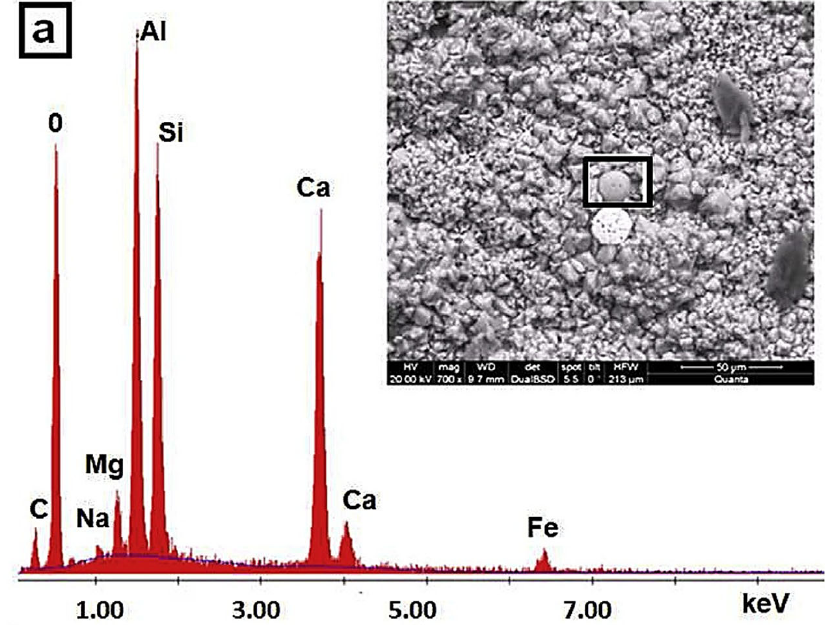
Figure 13. SEM and EDX curve showing the chemical composition of FA spots. Adapted from [49].